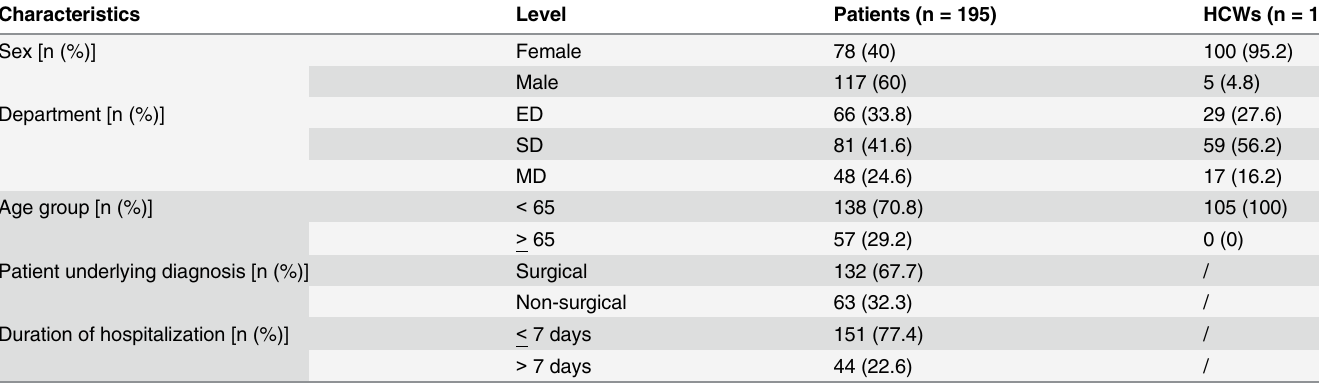
Table 1. Demographic characteristics of patients and healthcare workers (HCWs) at the Clinical Centre of Serbia,